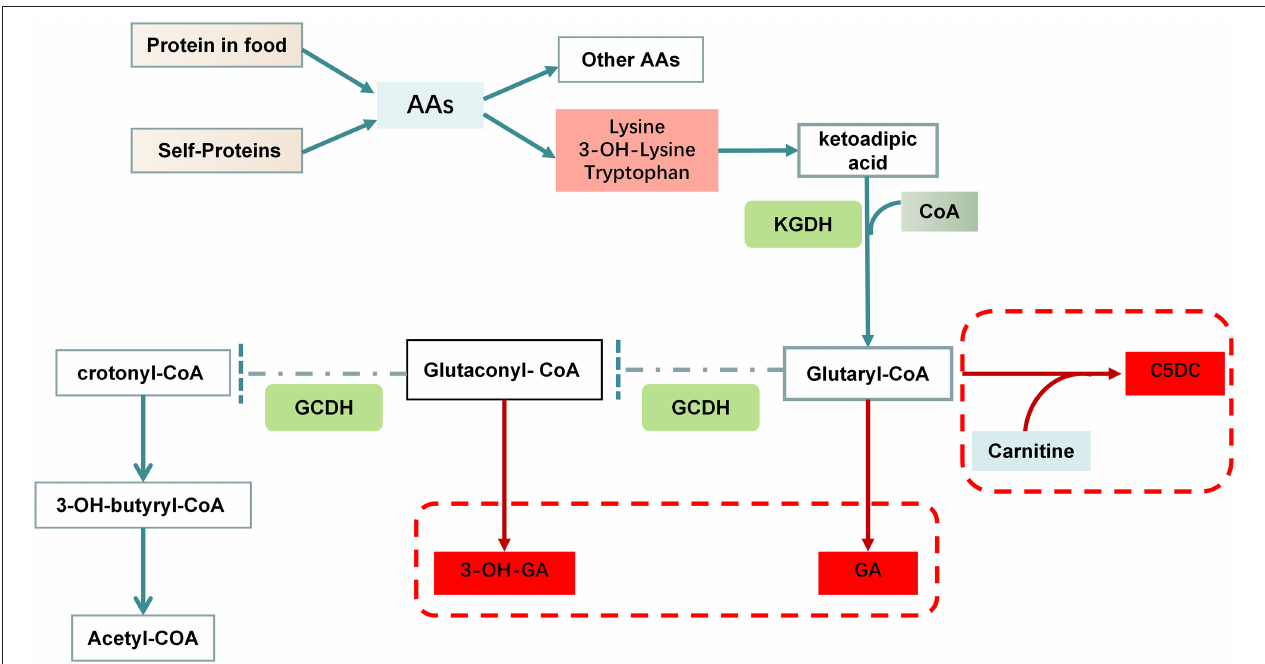
FIGURE 1 | Disorders of lysine and tryptophan metabolism in GA-I. Lysine and tryptophan enter cells through distinct sodium-independent facilitative amino acid transporters. These amino acids are converted to ketoadipic acid (KA) in the cytosol through glutamate/ketoglutarate-coupled transamination and transported into mitochondria. Subsequently, KA is oxidatively decarboxylated under the catalysis of α -ketoglutarate dehydrogenase (KGDH). It utilizes free CoA to form glutaryl-CoA, which can undergo conjugation with carnitine to form C5DC. Glutaryl-CoA dehydrogenase catalyzes the conversion of glutaryl-CoA to crotonyl-CoA in a two-step reaction, first dehydrogenated to glutaconyl-CoA, and second decarboxylated to crotonyl-CoA. A mutated GCDH enzyme cannot metabolize glutaryl-CoA to crotonyl-CoA resulting in accumulation of GA, glutaryl-CoA and 3-OH-GA, which have been proposed to act as endogenous neurotoxins.